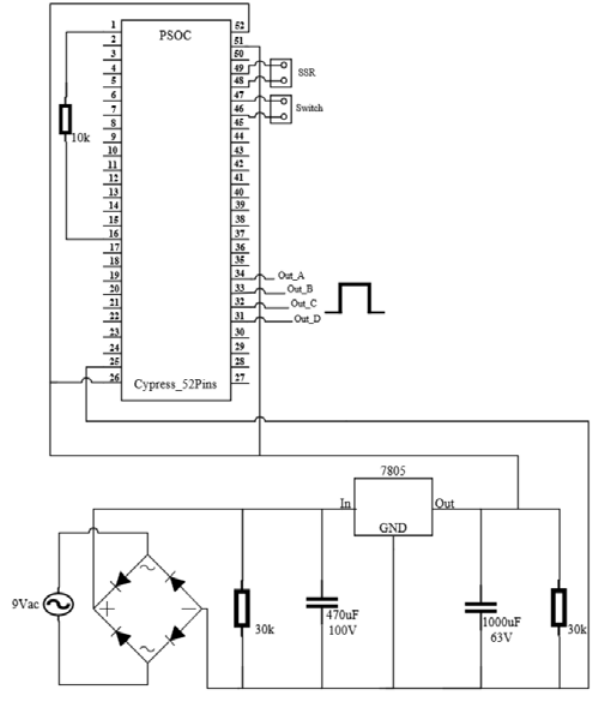
Figure 4. Pulse signal generator circuit.